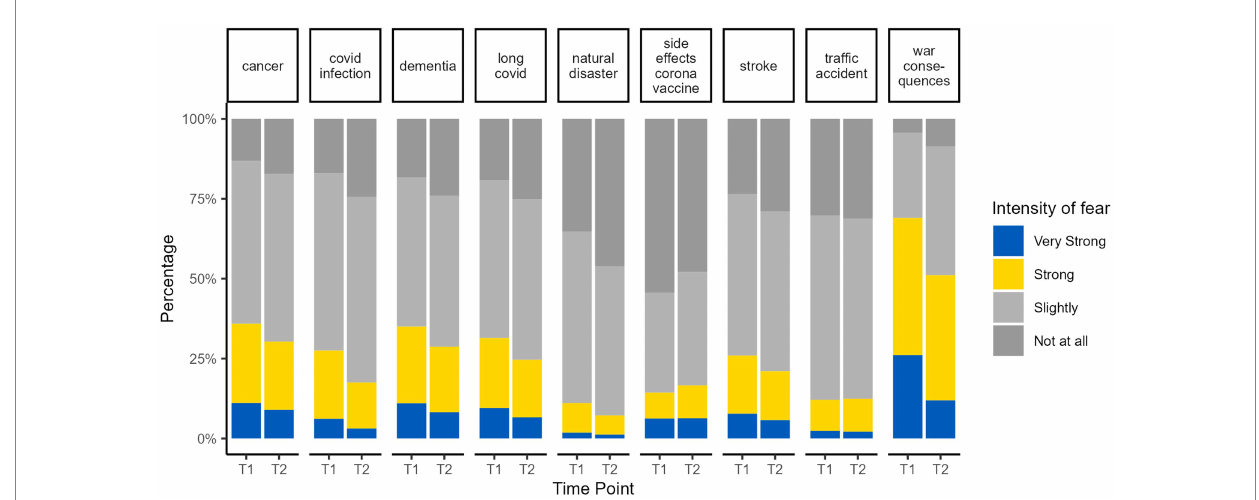
FIGURE 2 Fears of health related and other events at the start of the war (T1) and 6 month later (T2).